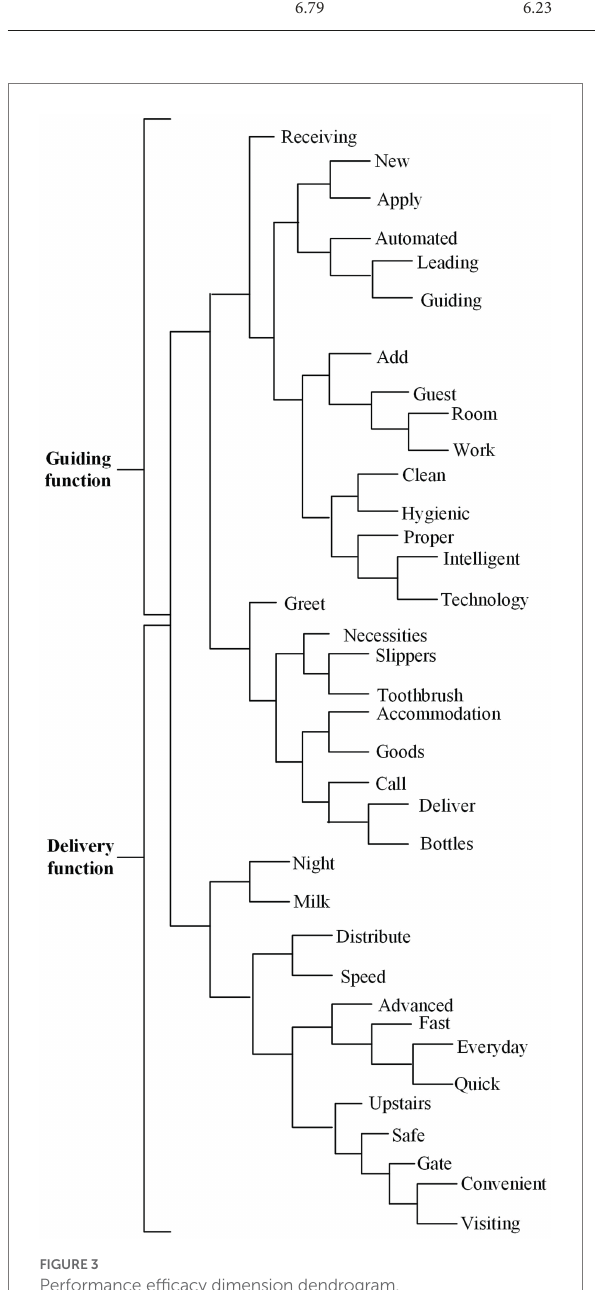
FIGURE 3 Performance efficacy dimension